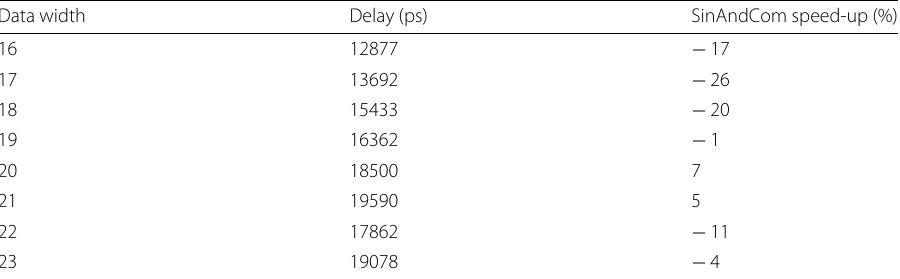
Table 7 Delay of the sine/cosine generators